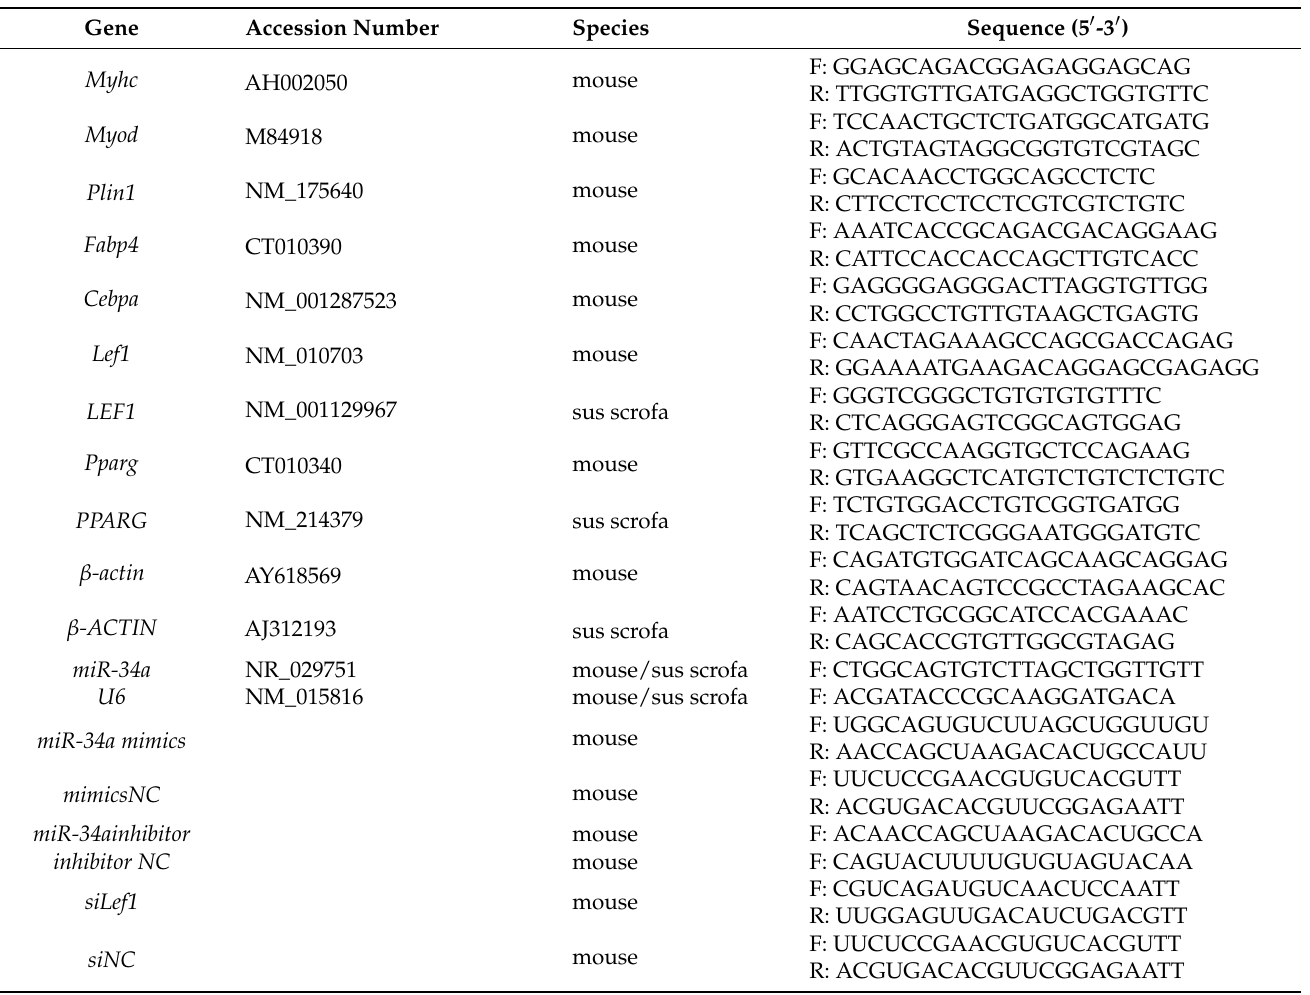
Table 1. All experiments were conducted at least three times. Relative gene expression was ∆∆ Cq calculated by the 2 − method using β -actin and U6 as the housekeeping genes. For Western blot, total protein was extracted using radioimmunoprecipitation assay (RIPA) buffer (Beyotime, Shanghai, China). A total of 20 µ g of protein was separated by SDS-PAGE and transferred to polyvinylidene fluoride (PVDF) membranes (Solarbio, Beijing, China). Membranes were then incubated overnight with primary antibodies as follows: anti-LEF1 (1:1000, ab137872, Abcam, Cambridge, MA, USA), anti-C/EBP α (1:1000, ab40764, Abcam, Cambridge, MA, USA), anti-PPAR γ (1:1000, ab272718, Abcam, Cambridge, MA, USA), anti- β -catenin (1:1000, ab32572, Abcam, USA), and GAPDH (1:1000, AF0006, Beyotime, Shanghai, China). All antibodies were diluted using Western dilution buffer (P0023, AF0006, Beyotime, Shanghai, China). The next day, the membranes were washed three times with Tris-buffered saline containing Tween 20 (TBST). Then, the membranes were incubated with a goat anti-rabbit IgG (1:1000, A0208, Beyotime, Shanghai, China), or goat anti-mouse IgG (1:1000, A0216, Beyotime, Shanghai, China) for 1 h at 4 ◦ C with shaking. Finally, the protein bands were visualized through an enhanced chemiluminescence (ECL) reagents (Beyotime, China), and the band intensities were quantified using a gel imager system (Alpha Innotech, San Leandro, CA, USA). The intensities of all the immunoblot bands were normalized to those of the corresponding internal standard bands (GAPDH). Table 1. Primers for qPCR analysis and the sequence of miR-34a mimics/inhibitor and si- Lef1 and their negative